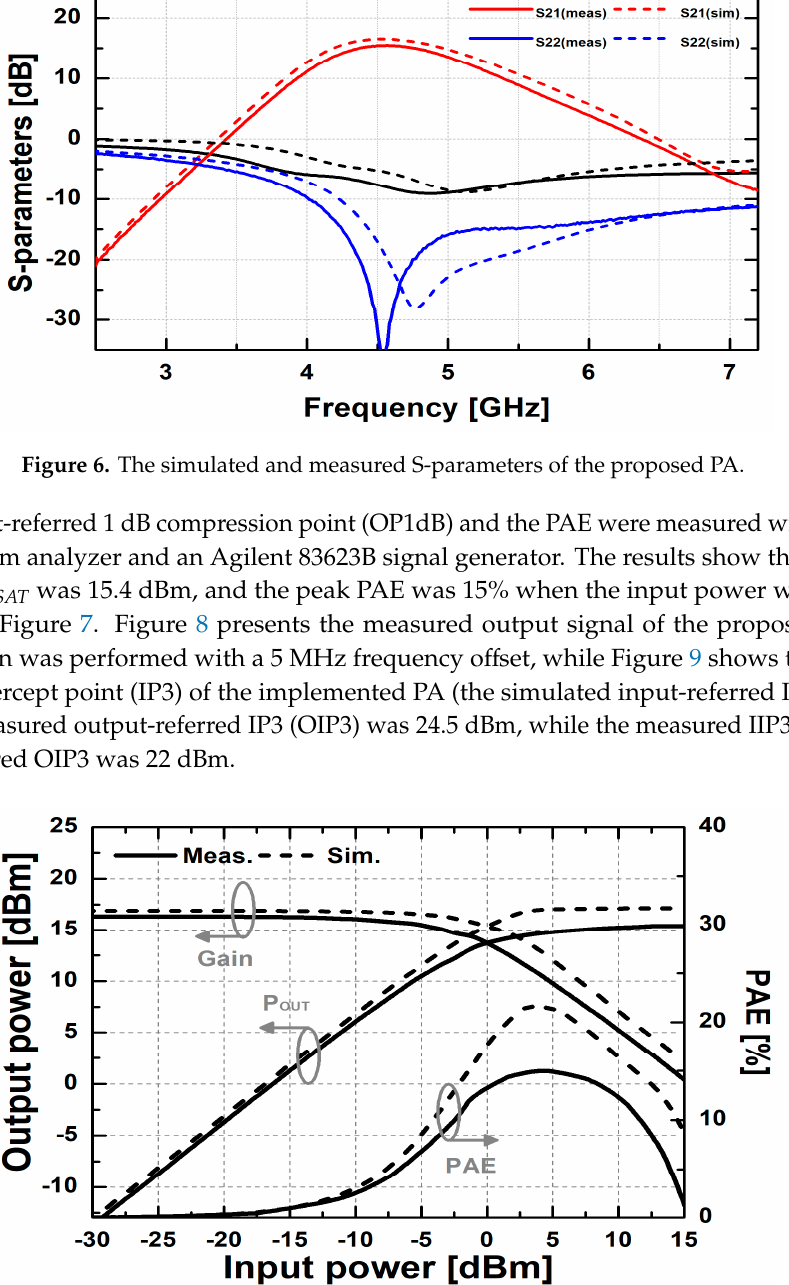
Figure 5. ( a ) Measurement and ( b ) probing setup of the proposed PA.